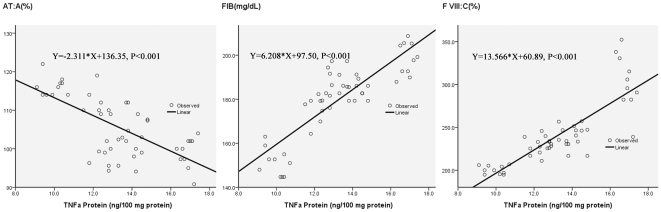
AT correlates with TNFα protein negatively. FIB and F VIII correlate with TNFα protein positively.